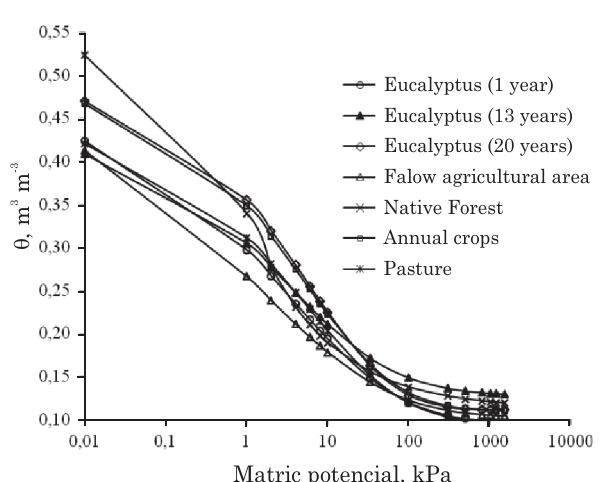
Figure 2. Soil water retention curves, adjusted by the van Genuchten model, in the 0.1-0.2 m layer as a function of soil